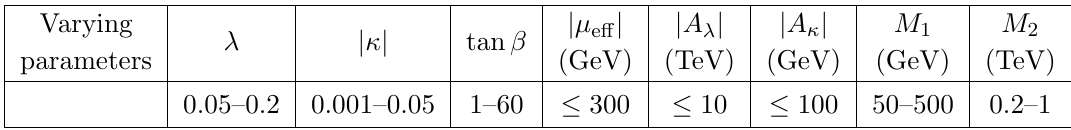
+ m 2 + m 2 ) = 4, except for ~ Q ~ U ~ D